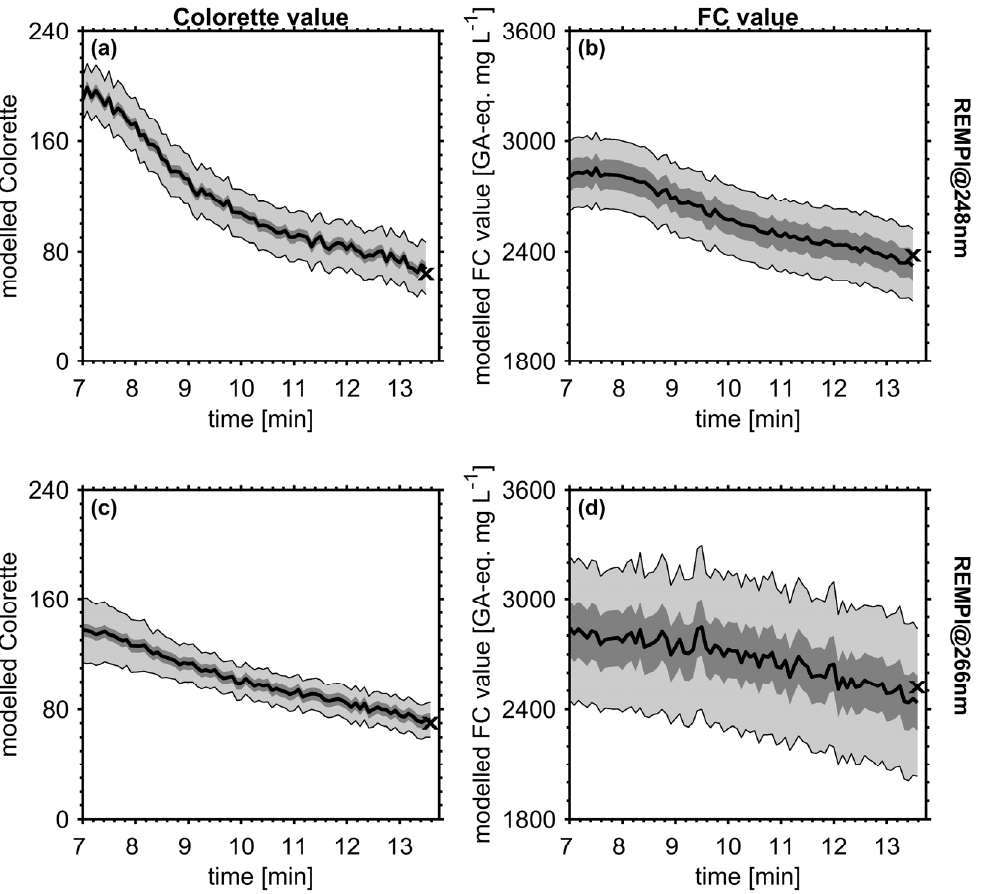
Figure 7. Application of PLS regression models for online prediction of Colorette (left) and FC value (right) within the range of calibration, enabling prediction of coffee properties in real-time (black line), with REMPI at 248 nm (upper panels ( a , b )) and 266 nm (bottom panels ( c , d )). Light grey-shaded area denotes the sample-specific prediction interval (PrI) with 95% confidence using Equation (17), dark grey-shaded area denotes a constant error interval using RMSE P . The symbol (x) refers to the values measured by Colorette and FC assay.